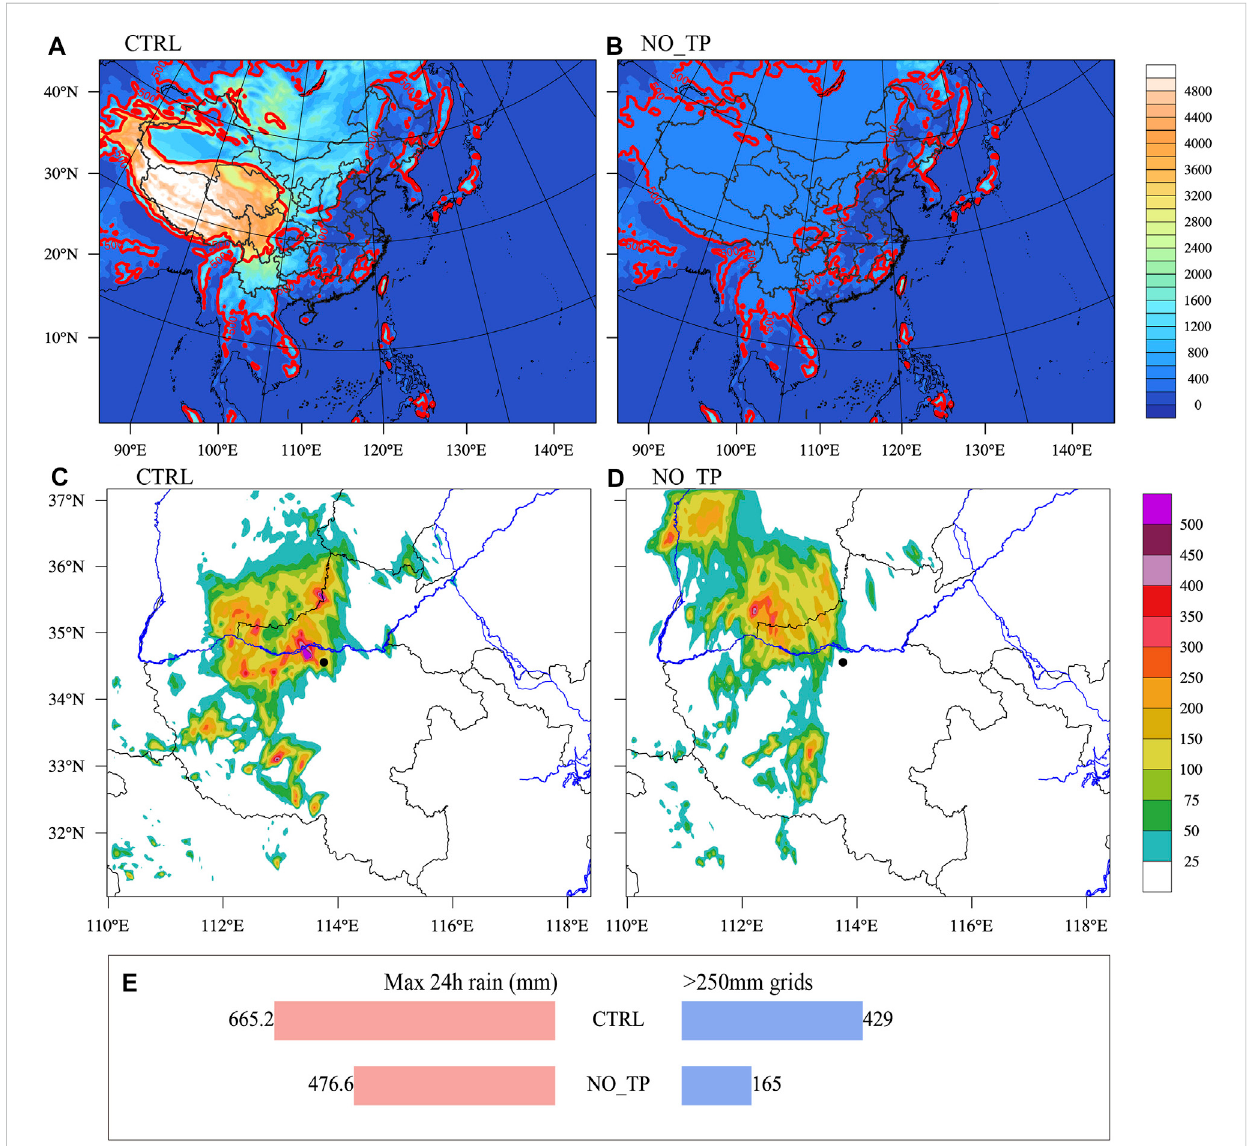
Comparison ofexperiment CTRLand NO_TP. (A – B) Terrain height(unit:m)oftheinitial fi eldat1900UTC. (C – D) 24 hprecipitation(unit: mm)from 0000 UTC July 20 to 0000 UTC 21 July 2021. (E) Histograms of the maximum 24 h precipitation (mm) from 0000 UTC July 20 to 0000 UTC 21 July 2021 and the number of precipitation grid points > 250 mm for the above